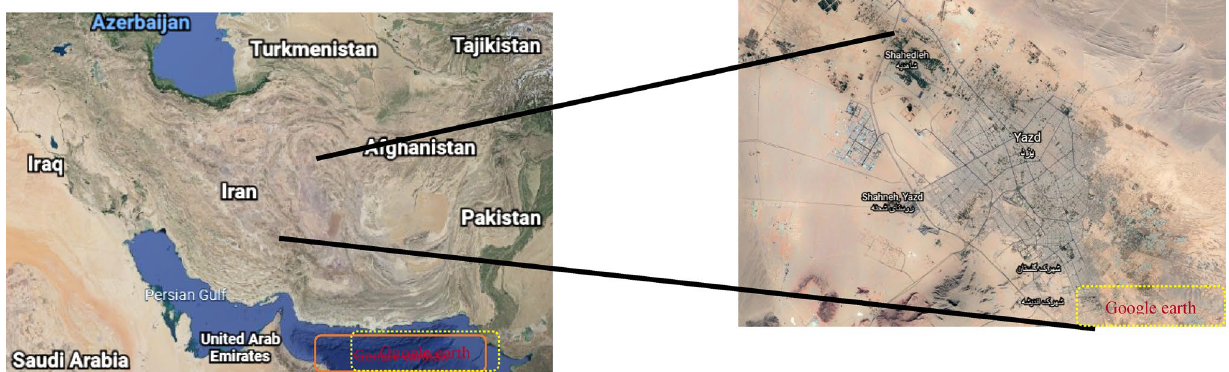
Figure 1. The geographical location of the study area. Maps of Iran-Yazd are available at: https:// earth. google. com/ web/ search/ iran/@ 32. 48376 657,54. 07653 009,1720. 21296 492a,25867 06. 88328 266d,35y,- 0h,0t,0r/ data= CigiJ gokCV-5_ 6ohZk BAEaV zQIn7 uz5AG YK1za KG3kx AIXKf RyghJ EpA and https:// earth. google. com/ web/ search/ yazd/@ 31. 87955 845,54. 33676 713,1228. 81847 223a,31608. 95482 31d,35y,0h,0t,0r/ data= Cm8aR RI_ CiUwe DNmYT YxOTk zMDM1 YjJhO TE6MH g1ZDk yYTE5 ZGQ3Z DRhMT BjGfK r3oa9 5T9AI fovxn atLUt AKgR5 YXpkG AIgAS ImCiQ JotZs LUxlQ 0AR11 C4YGj zNUAZ MIgmc wbTU0 Ahwko ZJxXb PEA in Google earth (2020),